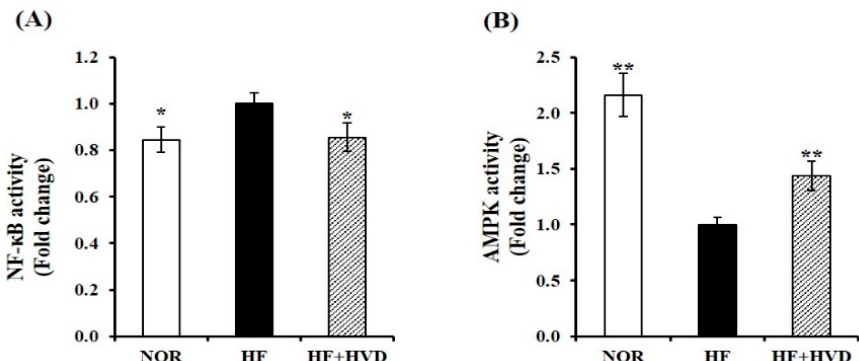
Figure 6. Influence of vitamin D supplementation on AMPK and NF- κ B activities. Commercial ELISA kits were used to measure nuclear ( A ) NF- κ B activity and ( B ) AMPK activation in epididymal WAT (eWAT) from obese mice. Results were normalized to their relative protein levels and presented as the fold difference compared to the HF group. Values are expressed as the mean ± SEM ( n = 9/group). NOR, 10% fat diet with 1000 IU vitamin D; HF, 60% fat diet with 1000 IU vitamin D; HF + HVD, 60% fat diet with 10,000 IU vitamin D. * p < 0.05; ** p < 0.01 compared to the HF group.